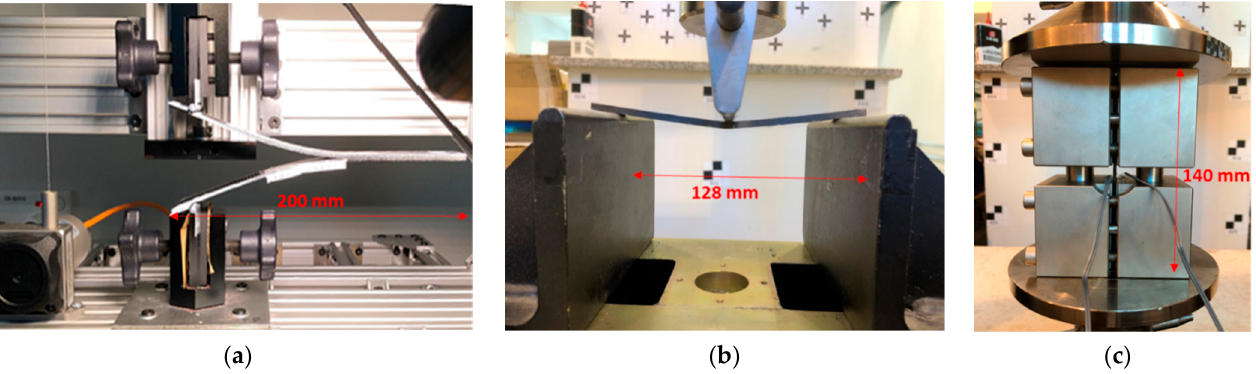
Figure 5. ( a ) Crack opening and crack location was measured by the attached scale with the zero-mark placed at the initial crack location. ( b ) Three-point bending setup for measuring strength in flexure. Specimen was placed between two supports while a loading nose applied the load at midspan. ( c ) Specimen placement in loading fixture between compression platens. Strain gauges were placed at the front and back of the specimen.